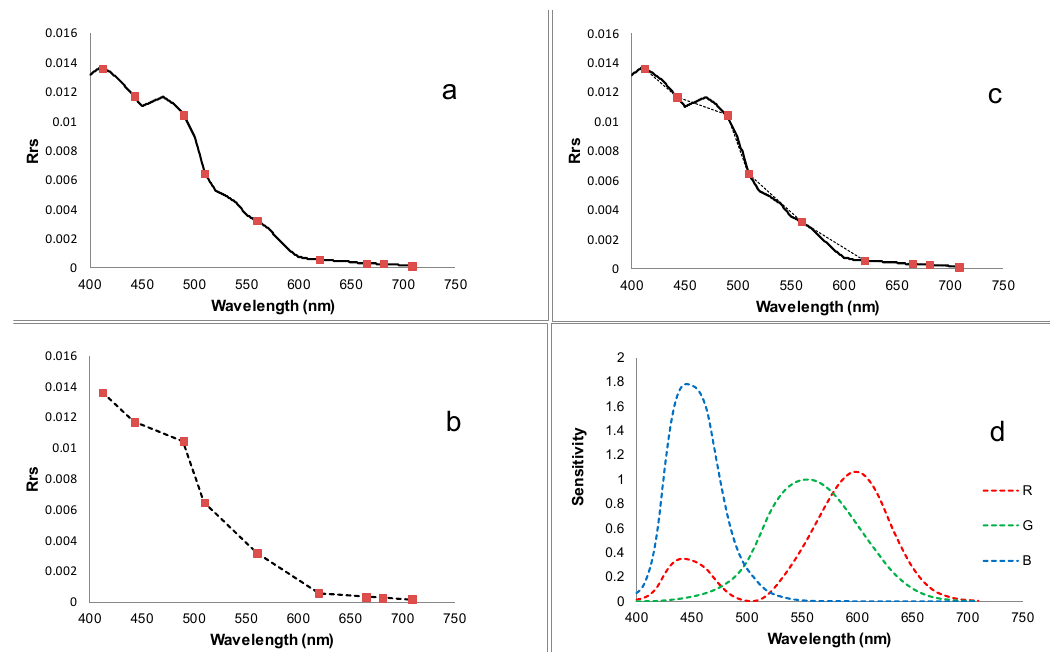
Figure 2. Original hyperspectral data plus red squares at the position of MERIS bands ( a ); the reconstructed spectrum from Rrs at nine MERIS spectral bands ( b ); a comparison of the two ( c ); and Colour Matching Function (CMF) curves for red, green, and blue that weight the spectral information to derive the hue angle ( d ).